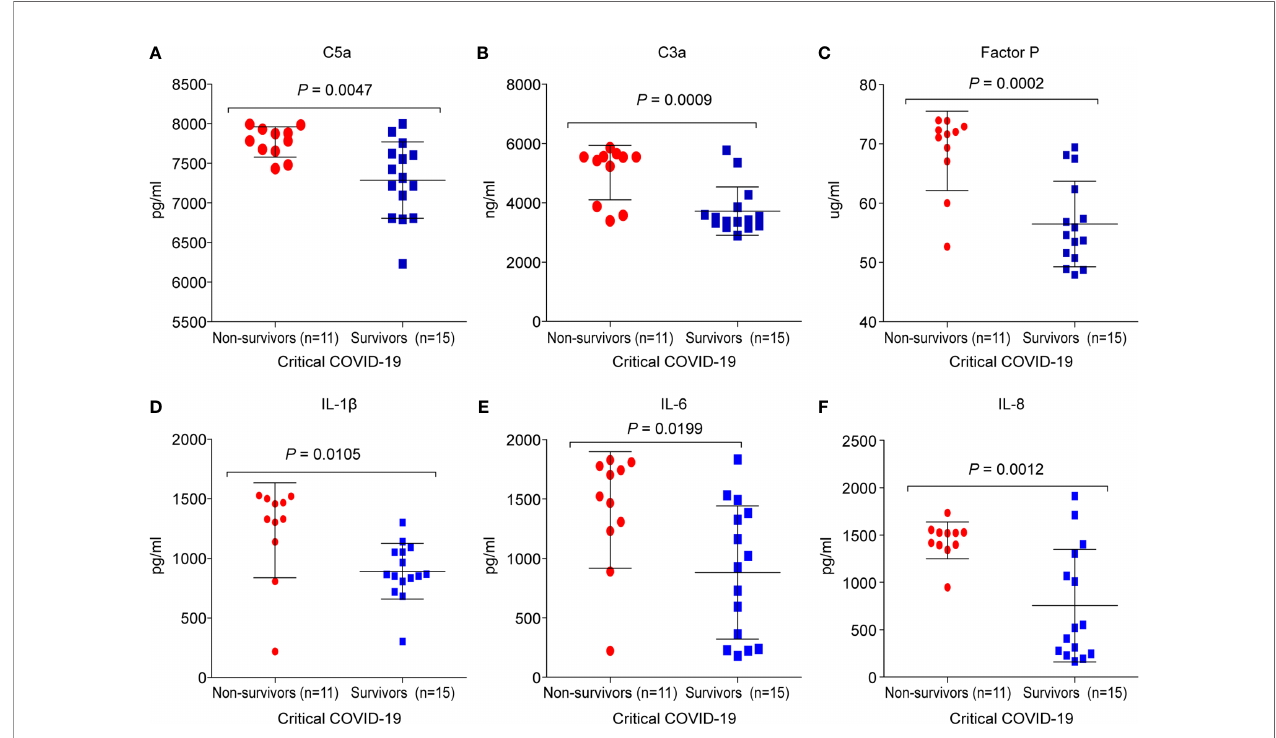
FIGURE 5 | Comparison of the complement proteins and cytokine/chemokine levels between critical COVID-19 patients who survived and those who did not survive. The serum samples were collected from the day of admission or day 14 during the intensive care unit (ICU)stay. (A) complement fragment C5a ( P = 0.005); (B) complement fragment C3a ( P < 0.001); (C) factor P ( P < 0.001); (D) interleukin 1 b (IL-1 b ) ( P = 0.01); (E) interleukin 6 (IL-6) ( P = 0.02); (F) interleukin 8 (IL-8) ( P = 0.001).